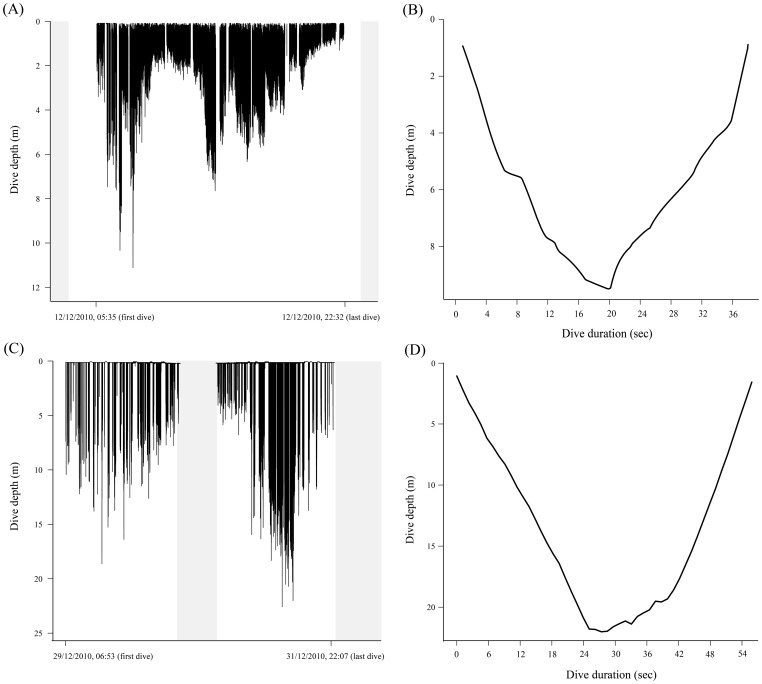
Example of the diving activity and a dive event of a common and a South Georgian diving petrel.Diving activity during the entire foraging trip and one dive of common diving petrel [(a) and (b), respectively] and South Georgian diving petrel [(c) and (d), respectively] measured with TDRs during incubation at Bird Island, South Georgia in summer 2010/11. Shaded areas indicate darkness.